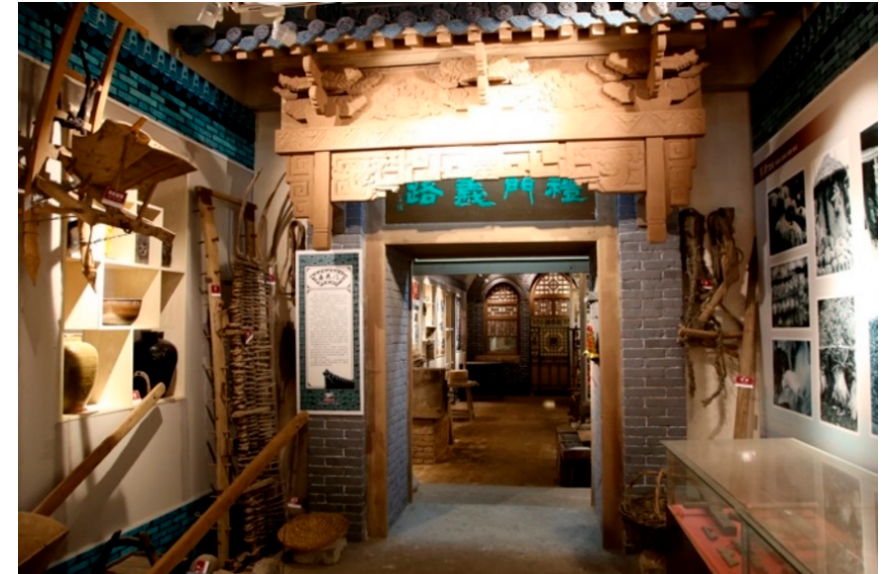
Figure 5. The community museum in Longwang Temple (© Lui Tam).